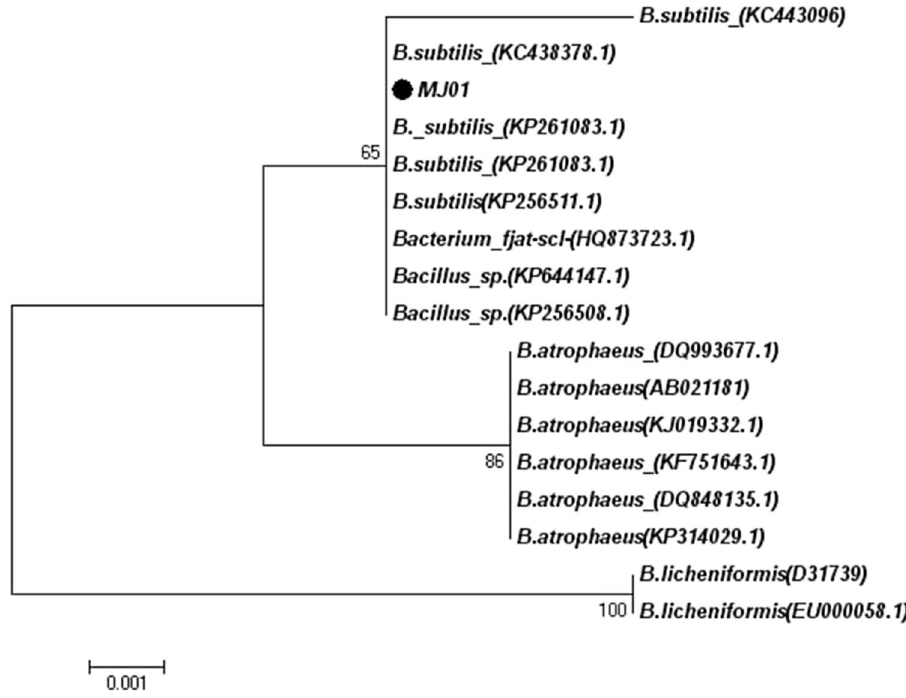
strain. CMC value is the intersection point of two lines, which